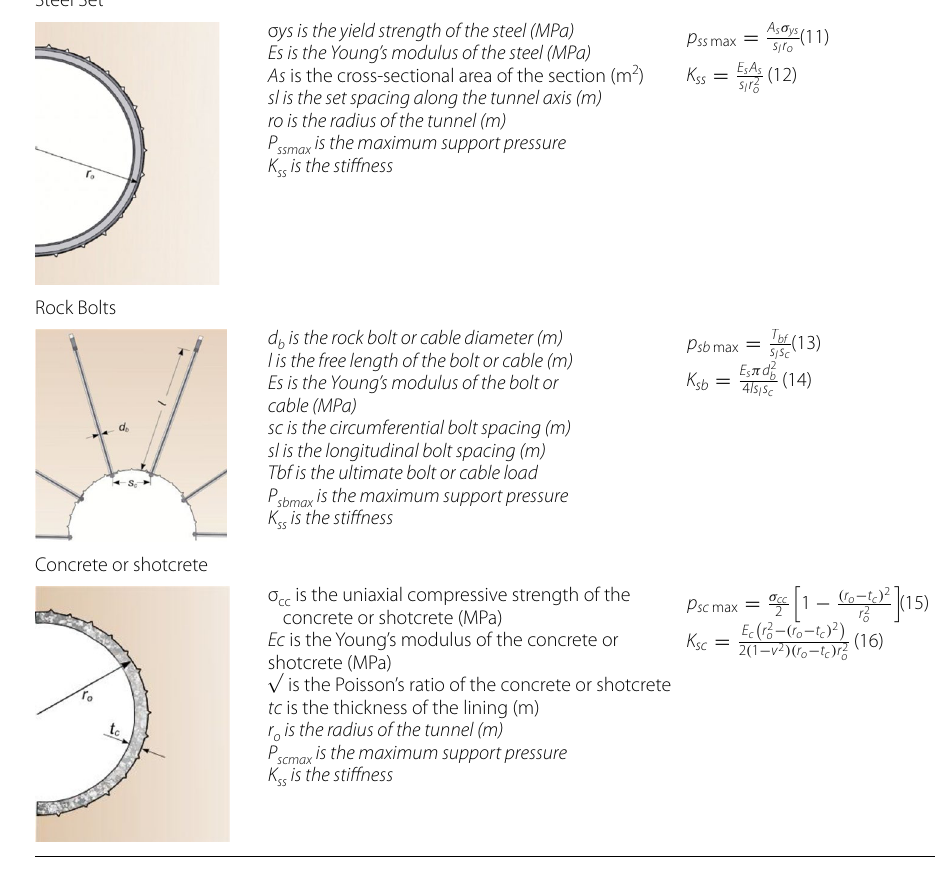
Table 3 Support capacity equations [44, 53] Steel Set